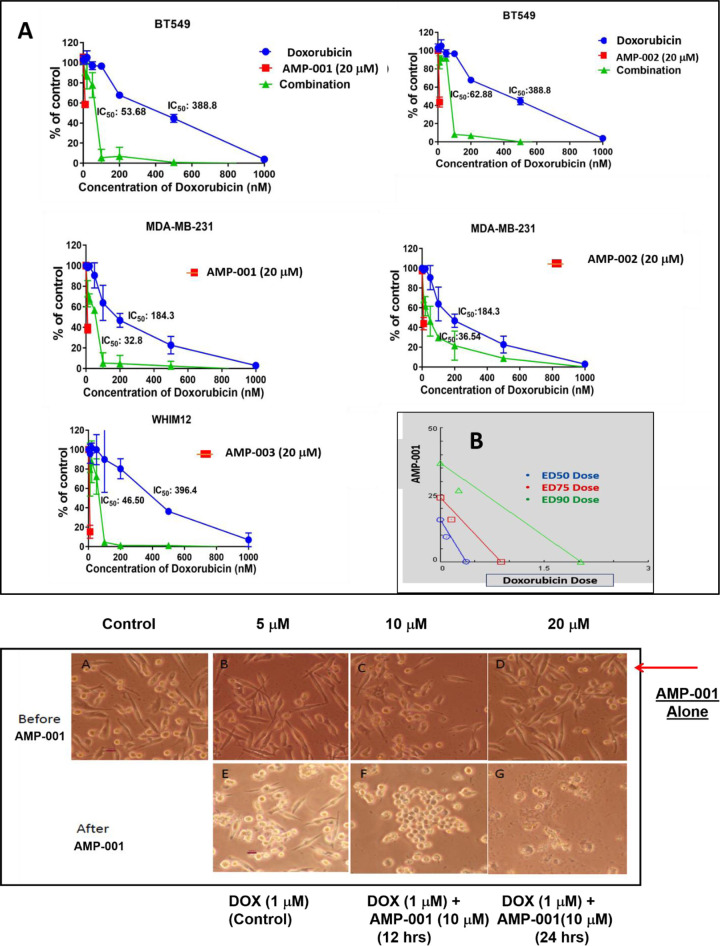
A) Representative IC-50 synergy curve (% of untreated control cell death Vs Doxorubicin dose) for AMP-001, AMP-002 and AMP-003, N = 4, P < 0.05, B) Representative combination index (CI) calculated at fractional kill Fa-50, Fa-75 and Fa-90 doses generating Isobologram (< 1.00, synergistic), CI range for combination of AMP-001 with doxorubicin or paclitaxel (see Table 1), N = 4, p< 0.05, C: Photomicrographs of synergistic effect of AMP-001 with doxorubicin in TNBC MDA-MB-231 cancer cells.